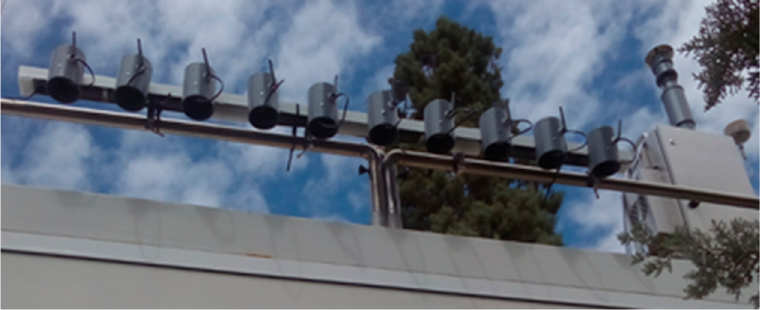
Figure 2. Field calibration of 10 EcoBici devices on the front of an Andalusian Council sampling station in Seville City.